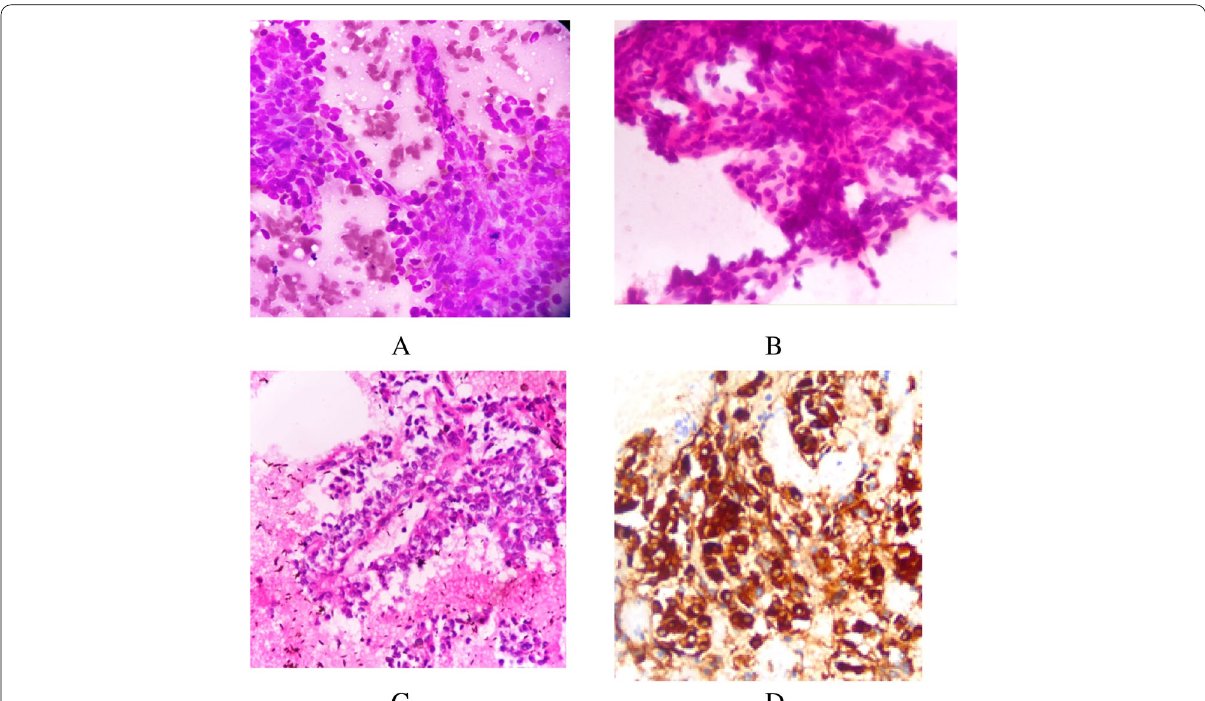
Fig. 2 Histological examination of solid‑pseudopapillary neoplasm of the pancreas. A DQ stain 400 power. B H&E stain 400 power. C H&E stain × cell block preparation 400 power. Smears of adequate cellularity revealed solid cellular smear patterns formed of cells with small round to oval, × occasionally grooved nuclei with finely granular even chromatin, and inconspicuous nucleolus with scant granular cytoplasm. Tumor cells surround myxoid vascular core stains magenta. D Immun‑stain with CD10, 400 power; tumor cells showed diffuse positive ×